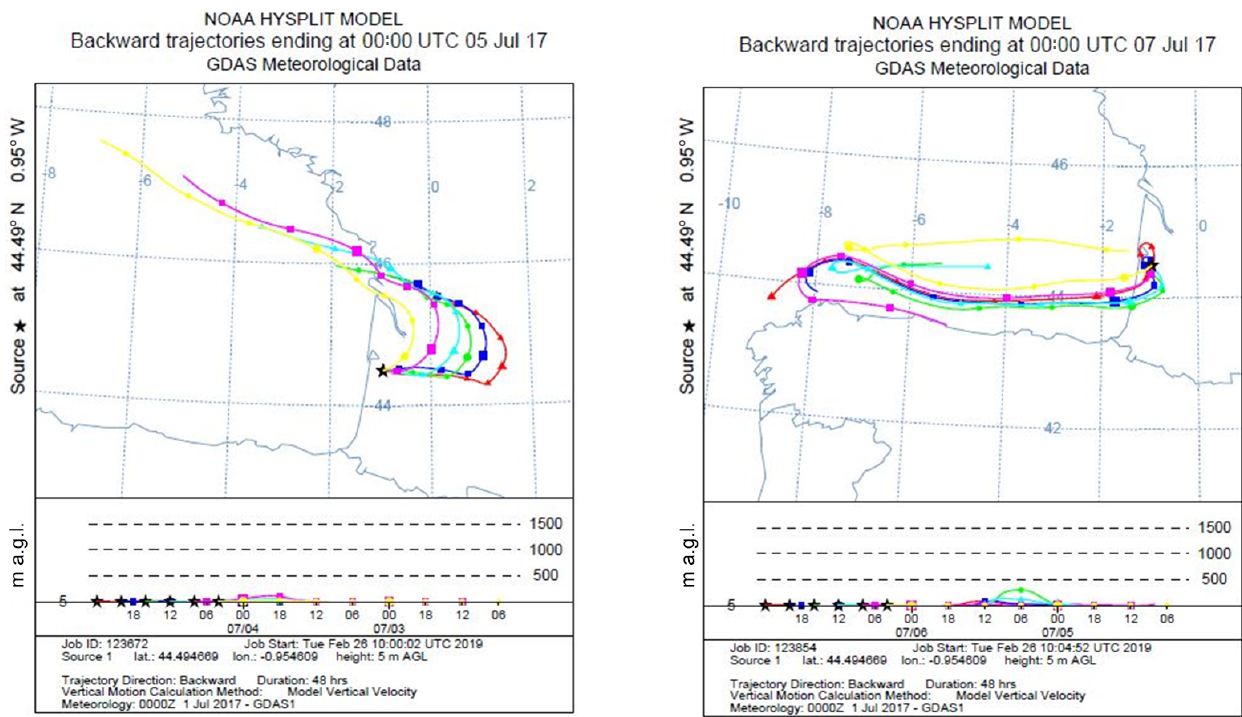
Figure 10. Air mass backward trajectories for the nights of 4–5 and 6–7 July. Red lines represent air masses arriving around midnight UTC (around 02:00LT – local time) to the site. The time difference between two points is